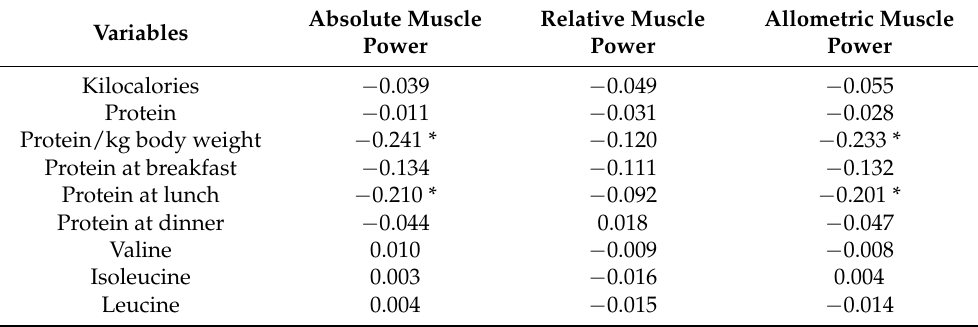
Absolute Muscle Relative Muscle Allometric Muscle Power Power Power